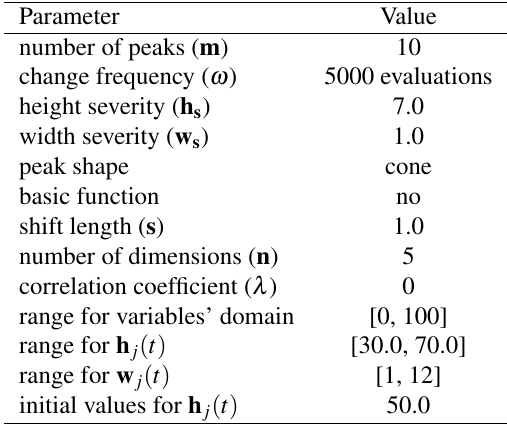
Table 1. Parameter configuration for the MPB